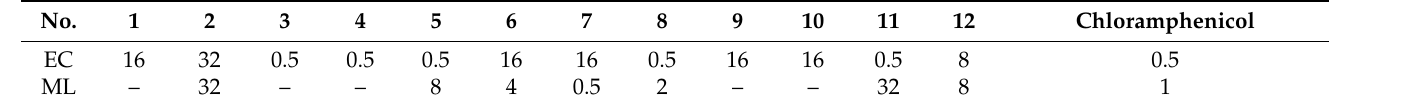
Table 3. Antibacterial activity of compounds 1–12 (MIC, µ